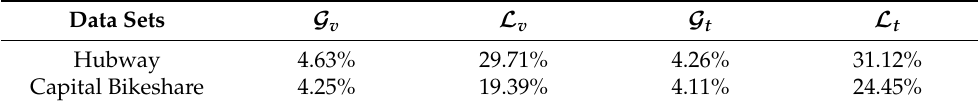
Table 2. Comparison of profit gain and lost demand reduction in the peak period (5 a.m.–12